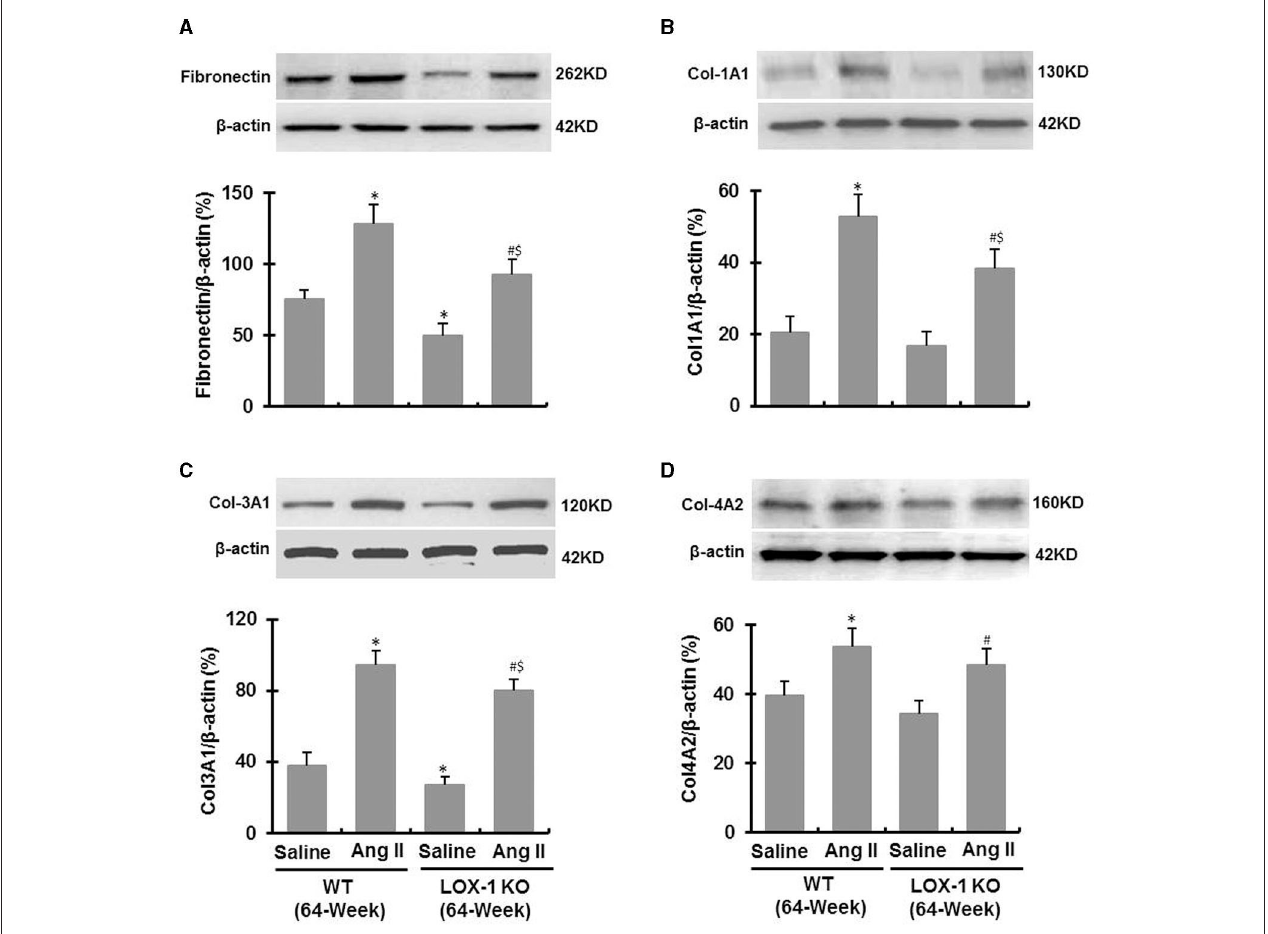
FIGURE 6 | Expression of fibronectin and collagens in the ventricle of each group of mice following infusion with Ang II or saline for 4 weeks (Western blotting). (A) Fibronectin expression; (B) Collagen-1A1 expression; (C) Collagen-3A1 expression; (D) Collagen-4A2 expression. n = 6 /group. * P < 0.05, vs. WT + saline group; # P < 0.05, vs. LOX-1 KO + saline group; $ P < 0.05, vs. WT + Ang II group.